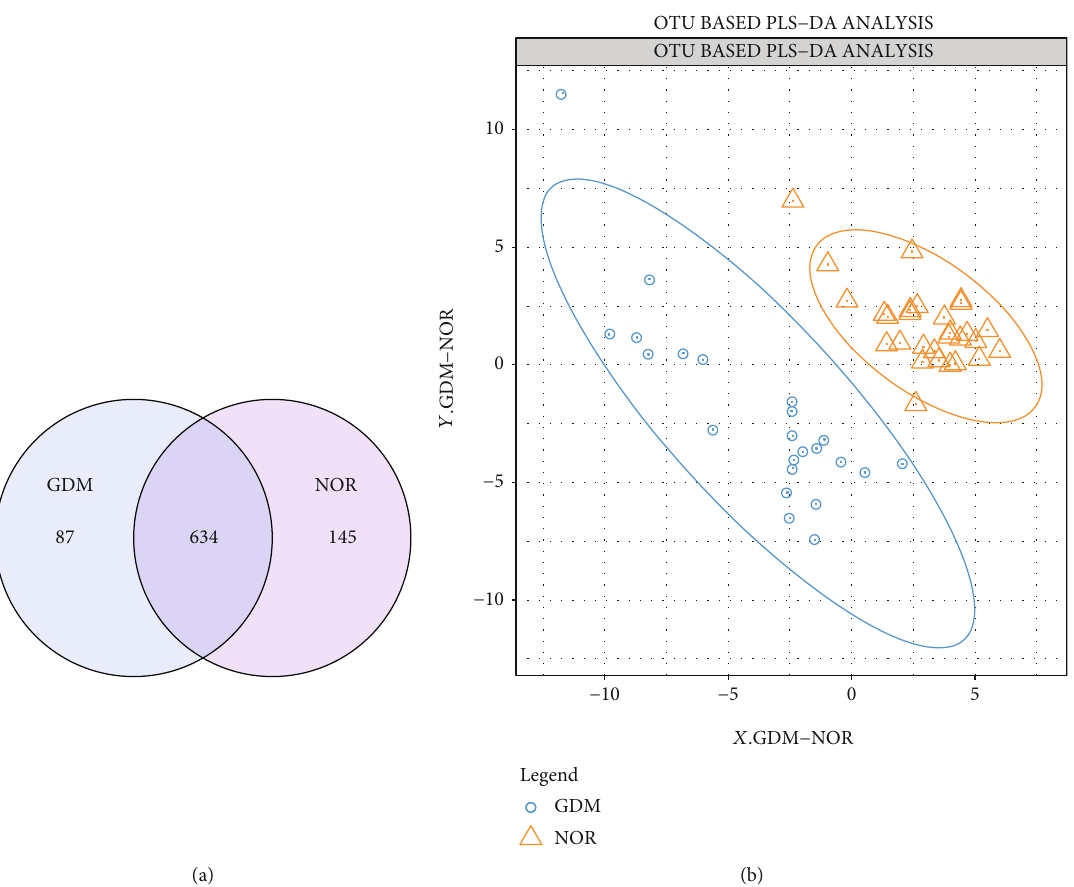
Figure 2: Comparison of the intestinal fl ora composition of the NOR and GDM groups. (a) Venn diagram showing the overlap of OTUs. (b) PLS-DA analysis of the di ff erence in intestinal fl ora between the NOR and GDM